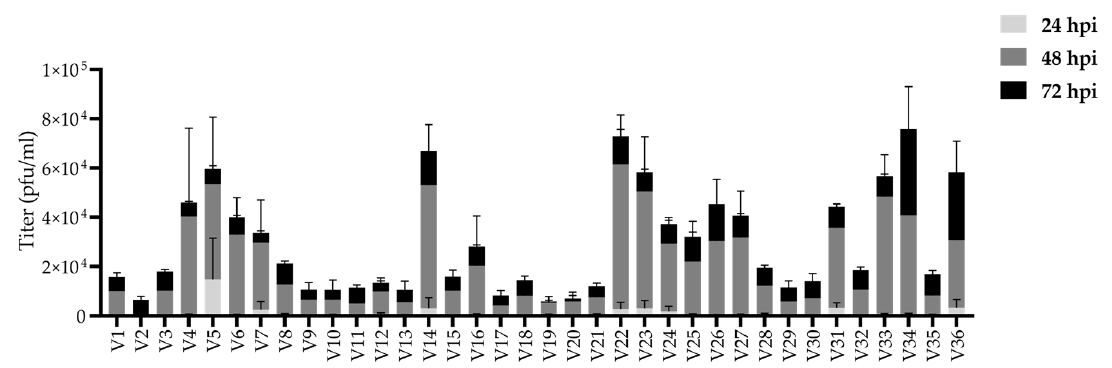
Figure 1. Cumulative virus yield of the clinical isolates in Vero cells. Vero cells were infected at 5 pfu/cell and quantified for any extracellular virus shed to the supernatant at 24, 48, and 72 h post infection (hpi). The yield of the virus in the supernatant is presented as stacked bars, so that the shed virus amounts from each time point are stacked on top of the yield from the previous time point. The light gray section (bottom section) represents mean of the virus yield at 24 hpi, the dark gray section (middle section) represents mean of the virus yield at 48 hpi, and the black (top section) section represents the mean of virus yield at 72 hpi. The whiskers represent the standard deviation of the mean for each time point ( N ≥ 4 per clinical isolate). The data is derived from four or more biological replicates for each clinical isolate.